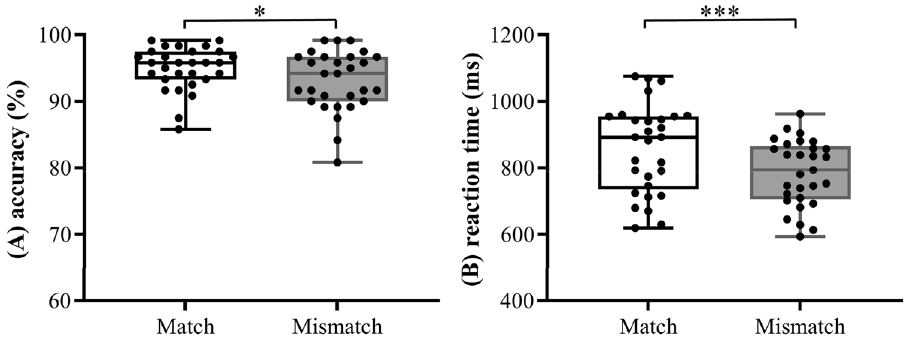
Figure 1. The boxplots of overall accuracy ( A ) and reaction times ( B ) in the Target-Catch match and mismatch conditions. The asterisk marks statistically significant differences (* p < 0.05, *** p <